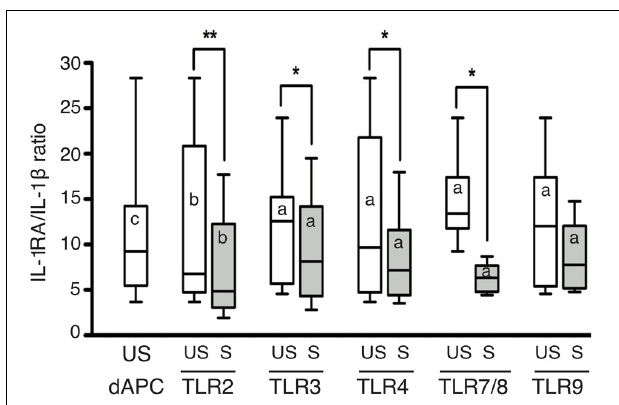
FIGURE 3 | Ratio of IL-1RA/IL-1 β secreted by CD14 + dMs after TLR2, TLR3, TLR4, TLR7/8, and TLR9 activation. The IL-1RA/IL-1 β ratio of unstimulated and stimulated dMs used for TLR2, TLR3, TLR4, TLR7/8, and TLR9 stimulation is reported (median and range). The IL-1RA/IL-1 β ratio of all unstimulated (us) dM samples used for the study is also reported to the left of the graph (median and range). A non-parametric paired permutation was performed between IL-1RA and IL-1 β secretion ( a p < 0 . 05, b p < 0.01, and c p < 0 . 001) and between unstimulated and TLR-stimulated